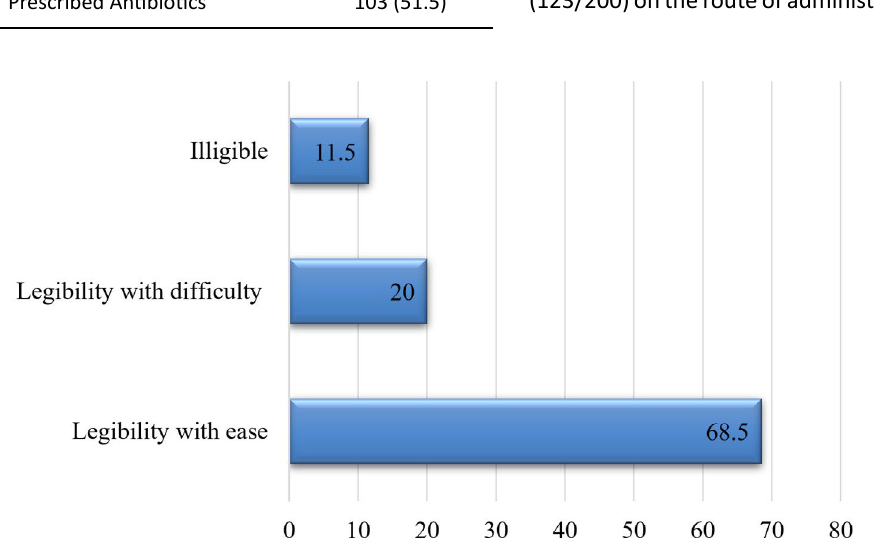
Fig. 1. Percentage of degree of legibility in the